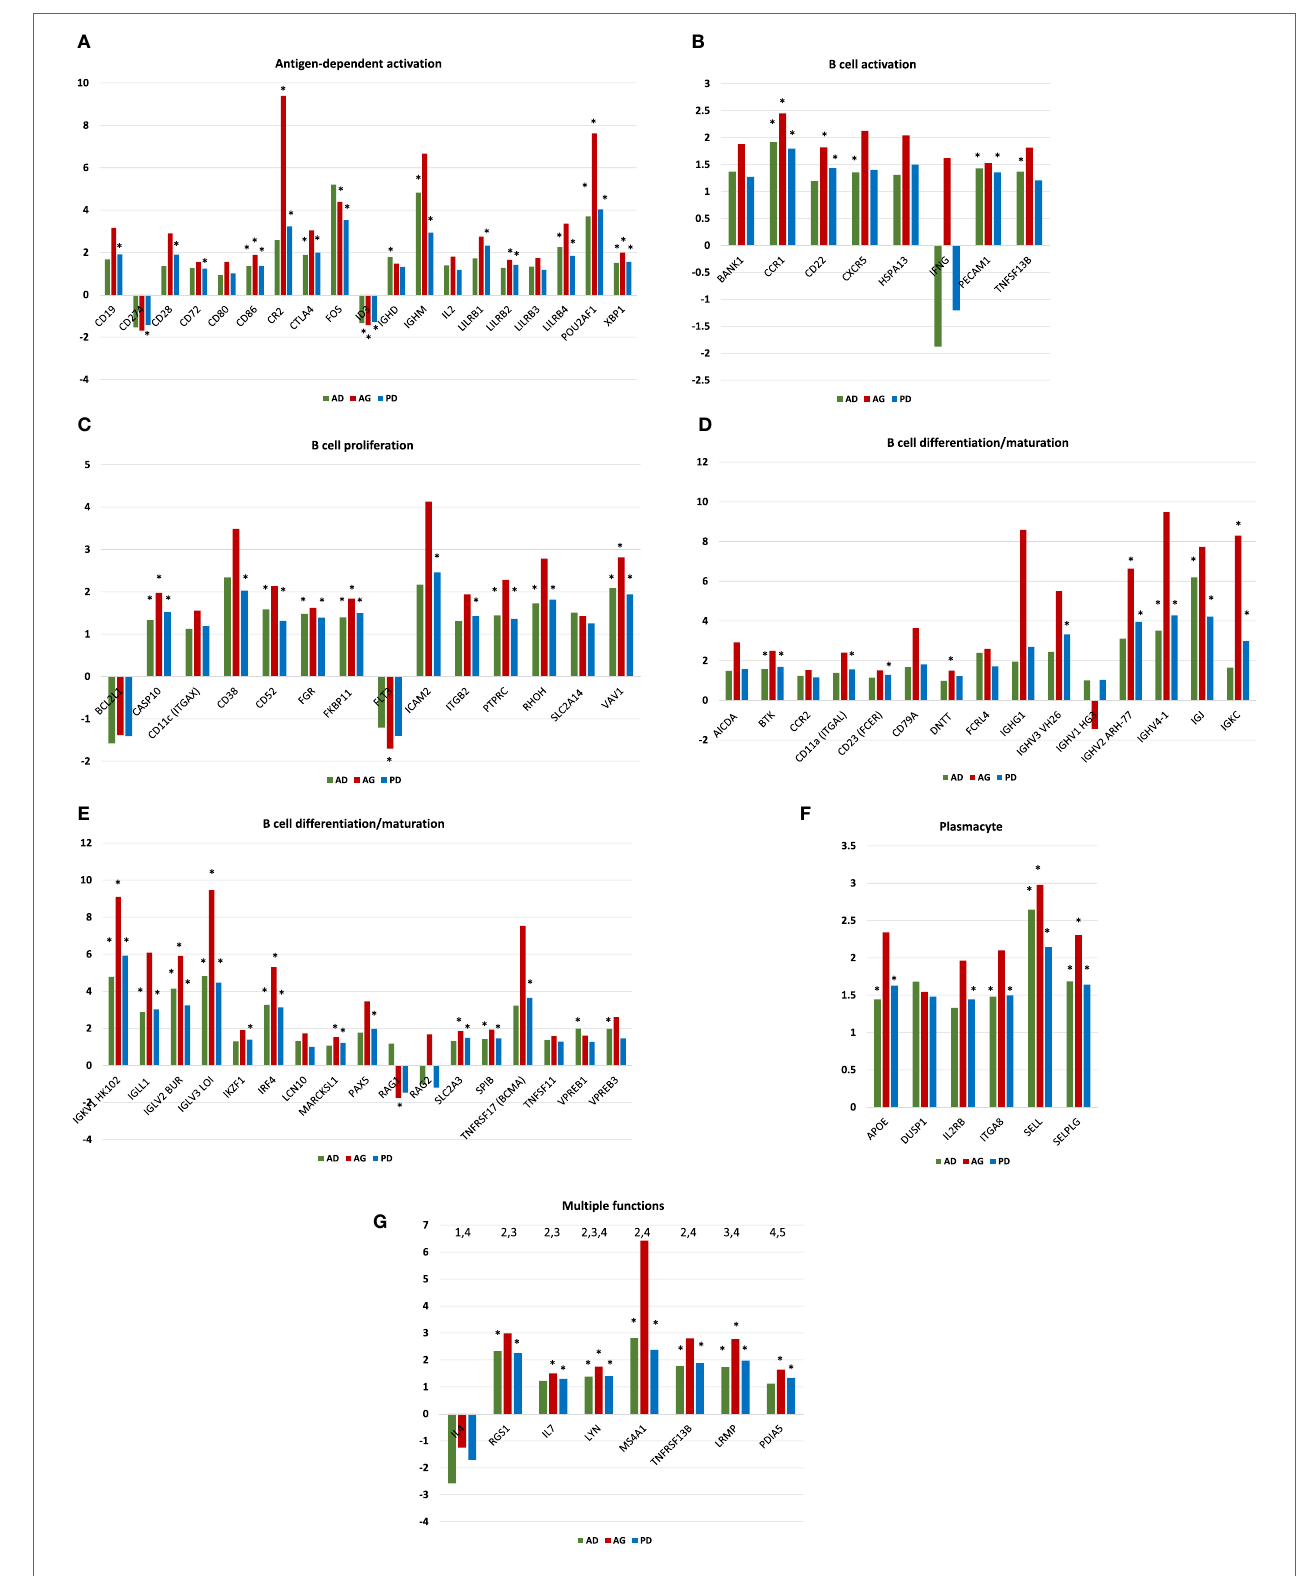
FigUre 3 | (a–g) Gene expression profiles of periodontitis from adult (AD), aged (AG), and overall periodontitis (PD) group compared with levels in healthy adult tissues for each of the various B cell/plasmacyte functional